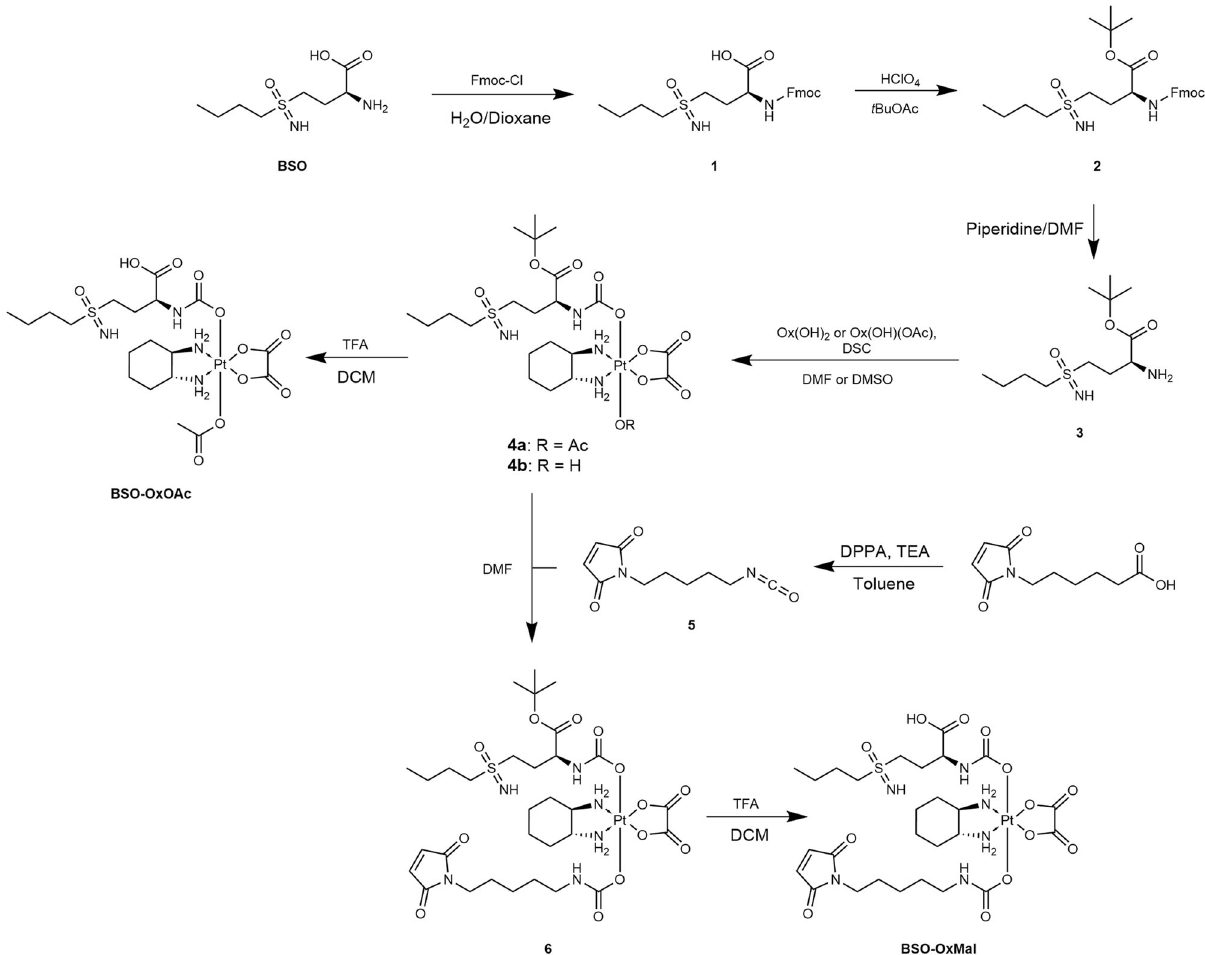
Fig. 1 Synthetic route to platinum(IV) prodrugs BSO-OxOAc and BSO-OxMal. The respective experimental conditions can be found in the Methods Section.